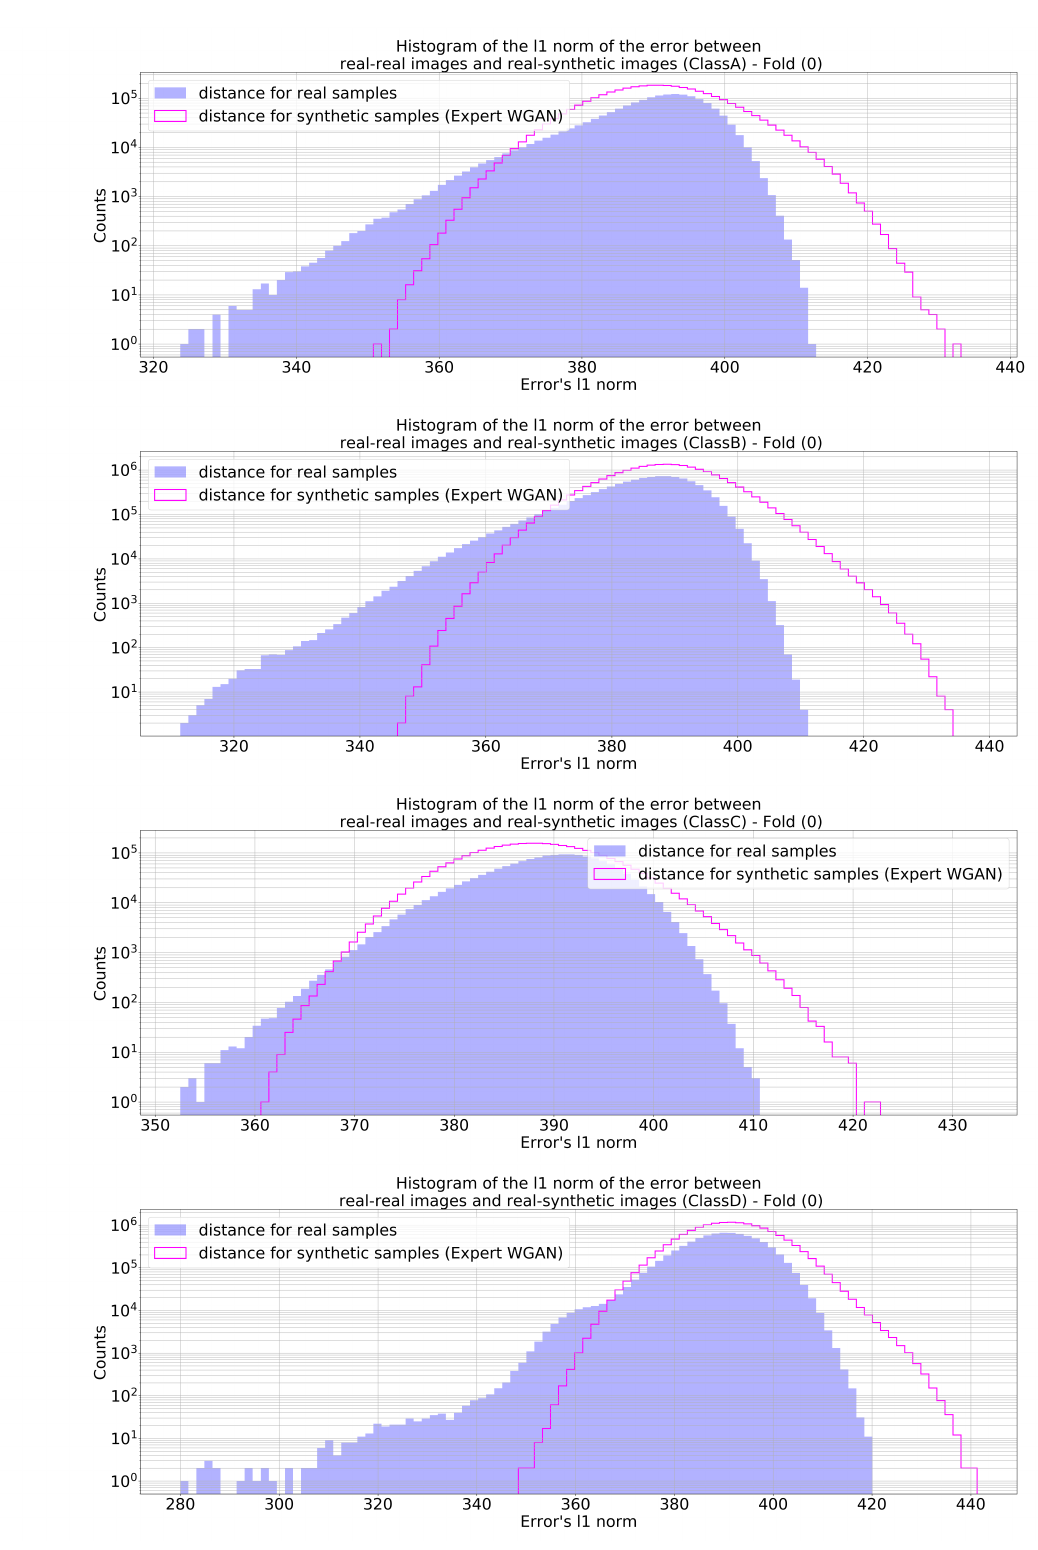
Figure 10. The (cid:96) 1 errors between real-real images and real-synthetic images. Real images were taken from the training set for the LORO-based